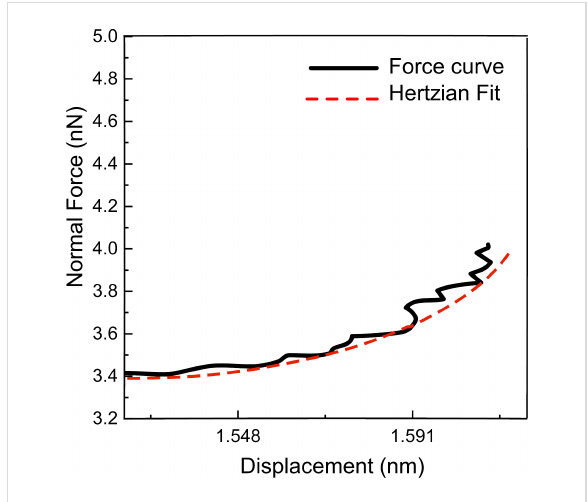
Figure 11: Force–distance curve from the static indentation measure- ment on an HOPG surface using a cantilever with a stiffness of 39 N/m. The force versus displacement (black curve) was fit with a Hertzian contact (red curve) to extract the elastic modulus. The radius of the tip apex that made contact with the surface was 11 nm.